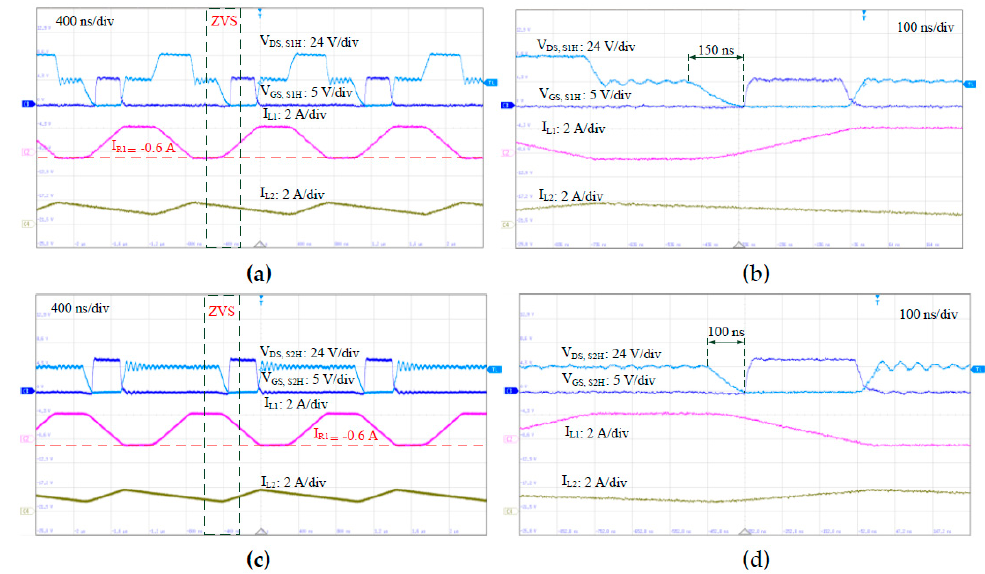
Figure 12. Experimental waveforms at 20% load in forward direction: ( a ) resonant period of S 1H ; ( b ) detailed ZVS of S 1H ; ( c ) resonant period of S 2H ; ( d ) detailed ZVS of S 2H